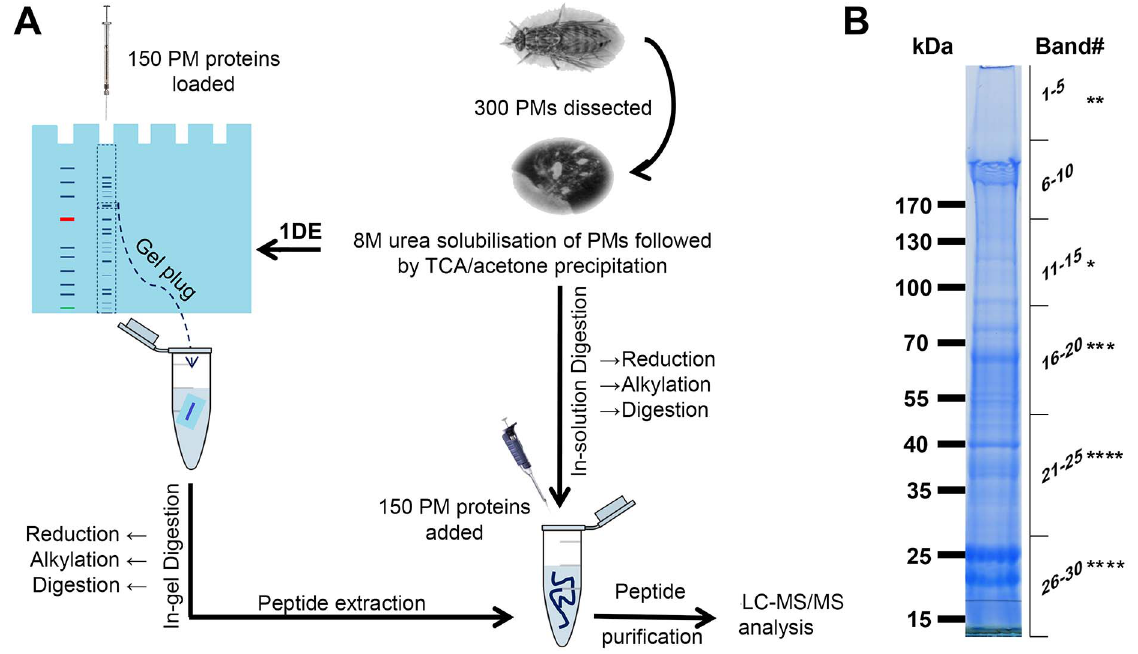
Figure 1. Experimental flow diagram. A total of 300 PMs were dissected and split equally into 2 tubes for urea/SDS solublisation and acetone precipitation. (A) One batch of PMs were sent directly for in-solution trypsin digestion whilst the other were fractionated on a 4–20% gradient gel. (B) 30 bands were cored from the gel from top to bottom and each gel plug was processed for in-gel trypsination mass spectrometry analysis. The position and number of asterisks indicate the regions of the gel where GmmPer66 was identified.